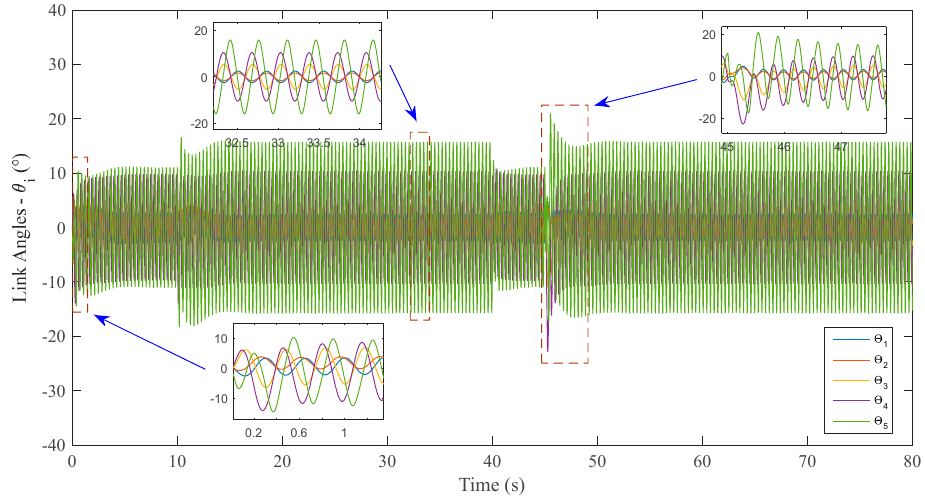
Figure 12. Link angles of the robotic fish for free-swimming motion during 80 s simulation time.